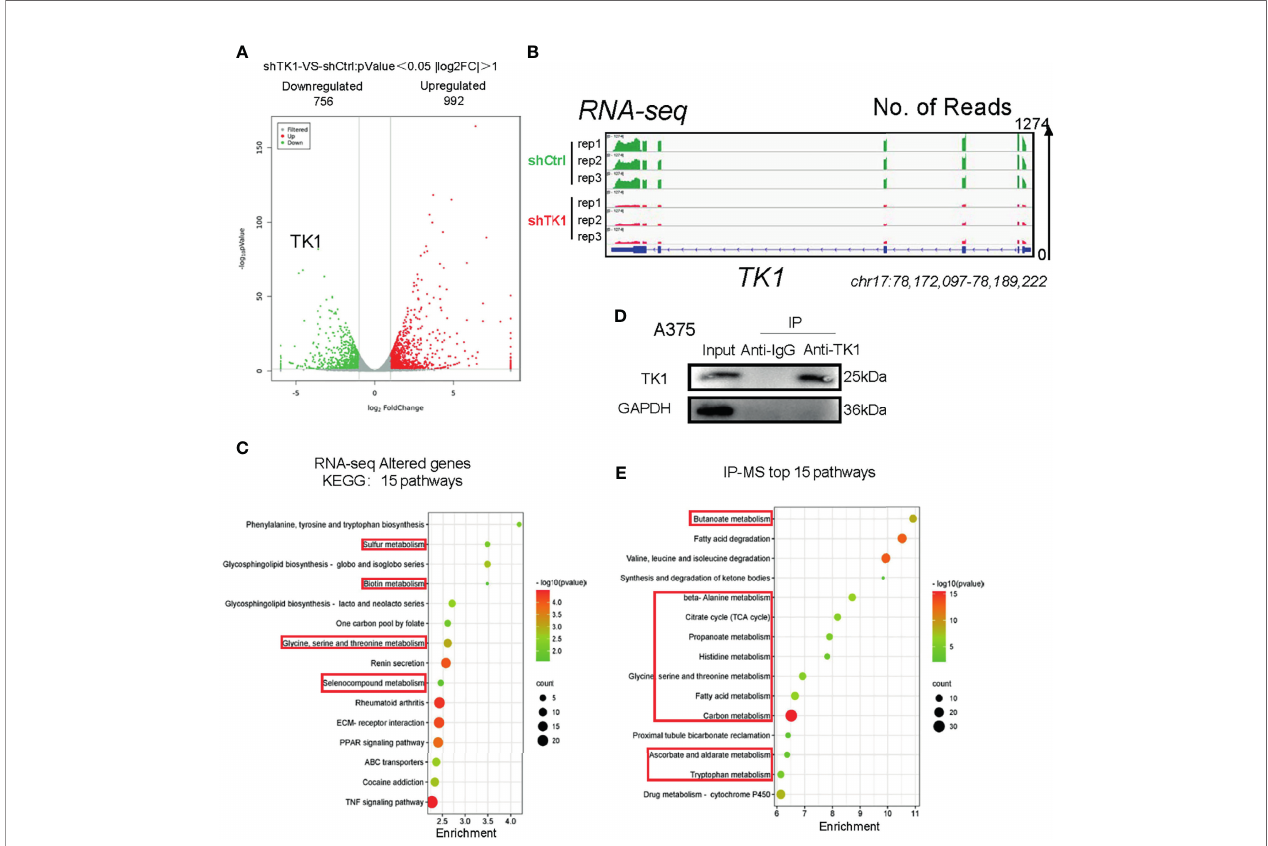
FIGURE 4 | Thymidine kinase 1 (TK1) was associated with skin cutaneous melanoma (SKCM) cell metabolism disturbance. (A) Altered genes with TK1 knockdown in SKCM. |log2FC| >1, p < 0.05. (B) Integrative Genomics Viewer (IGV) shows the expression of TK1 in knockdown/control group. The data range was set to 1,274. (C) Fifteen pathways of top enrichment of changed genes with TK1 knockdown. (D) Western blot con fi rmed that TK1 was puri fi ed successfully in lysate and had no impurity. (E) Fifteen top enrichment pathways of all genes that corresponded to proteins interacting with TK1; most were relevant to intracellular metabolic